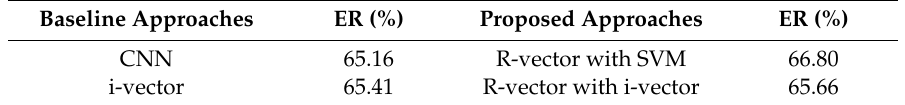
Table 9. Performance (Error Rate (ER)) of three-class LID experiments on the 2011 NIST LRE test set.